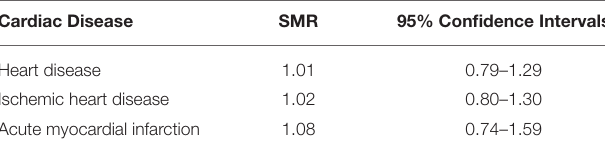
TABLE 5 | Meta–analysis of US, UK, and German cohort mortality